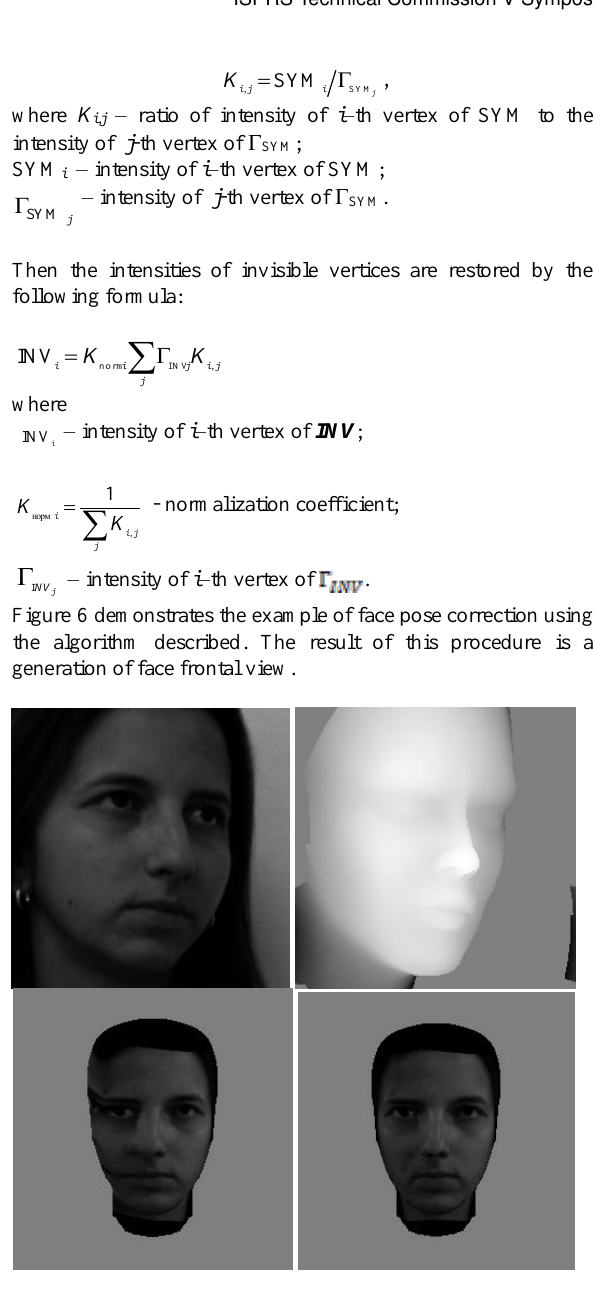
Figure 6. Example of face pose correction